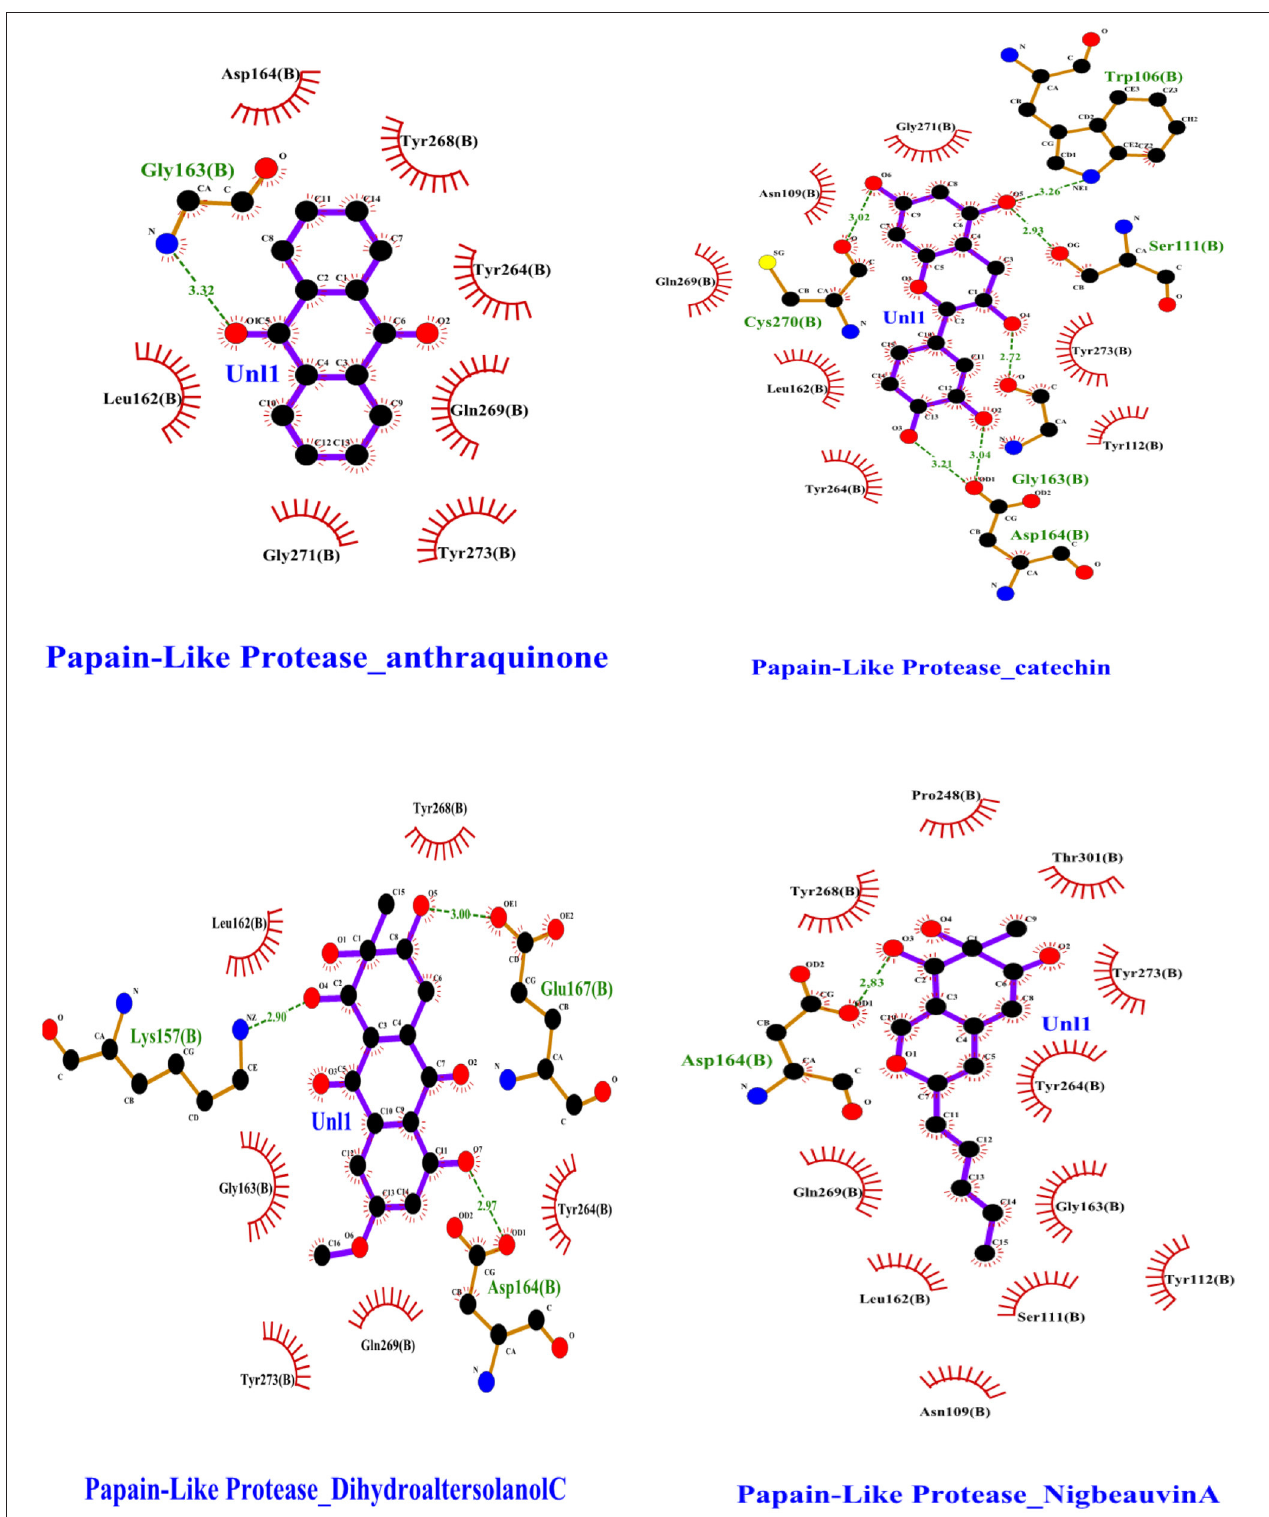
FIGURE 1 | Interactions of the selected bioactive molecules and SARS-CoV-2 Papain-Like Protease (Plpro) binding pocket residues. For all the bioactive molecules, carbon atoms are shown in black, oxygen in red, and nitrogen in blue. Bonds in the Anthraquinone, Dihydroaltersolanol C, Catechin, and Nigbeauvin A.